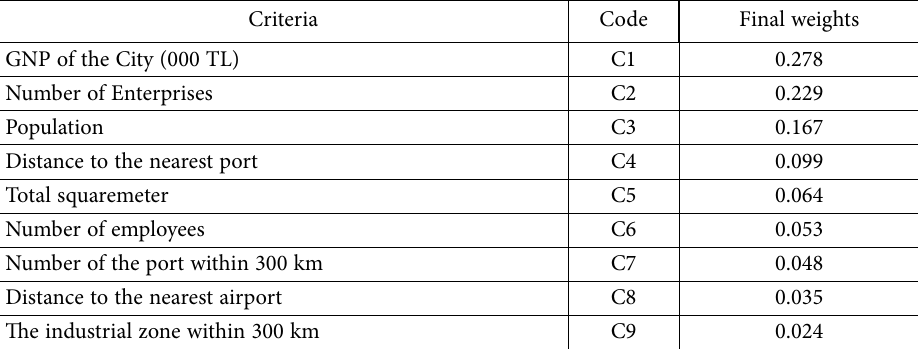
Table 6. The final criteria